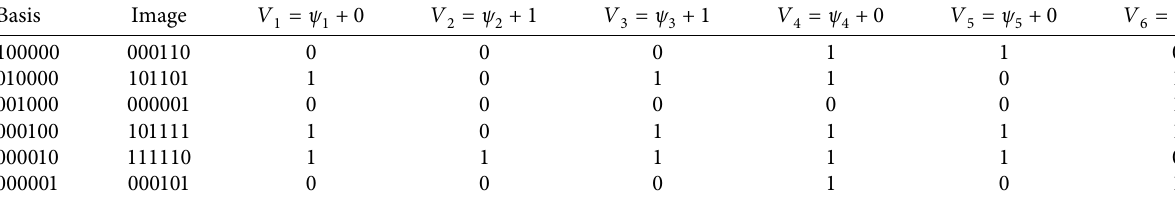
Table 3: Mappings of basis elements to the Modified Weidemann.